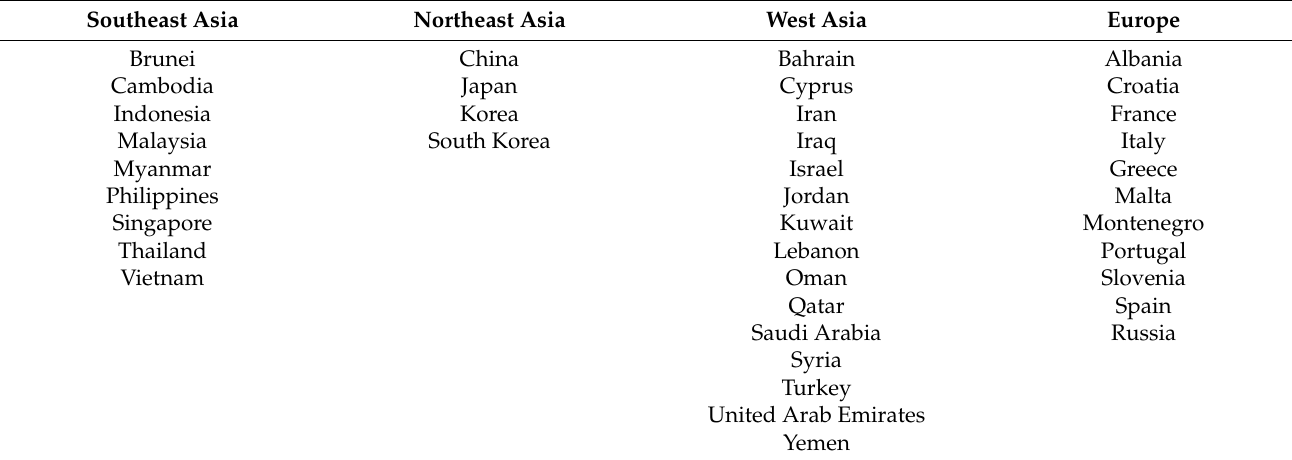
Table 3. List of dominant regional